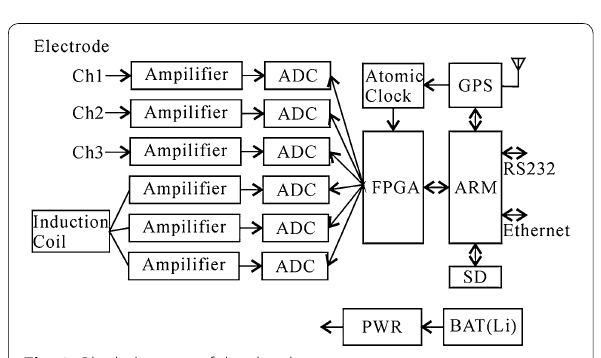
Fig. 9 Block diagram of the data